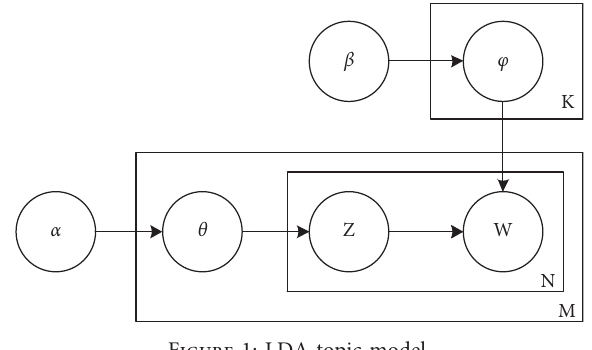
Figure 1: LDA topic